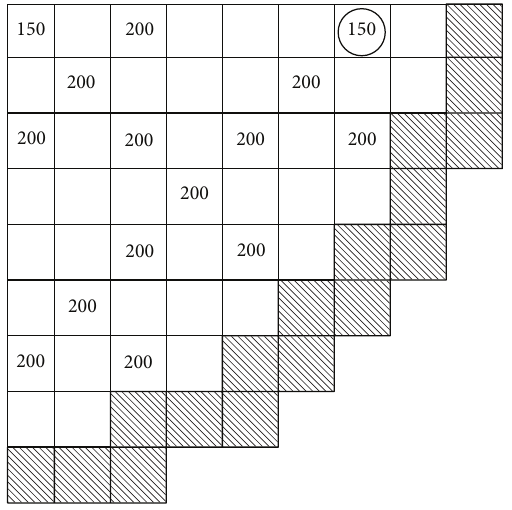
Figure 3: The initial control rod positions for case A2 (circled position is ejected).